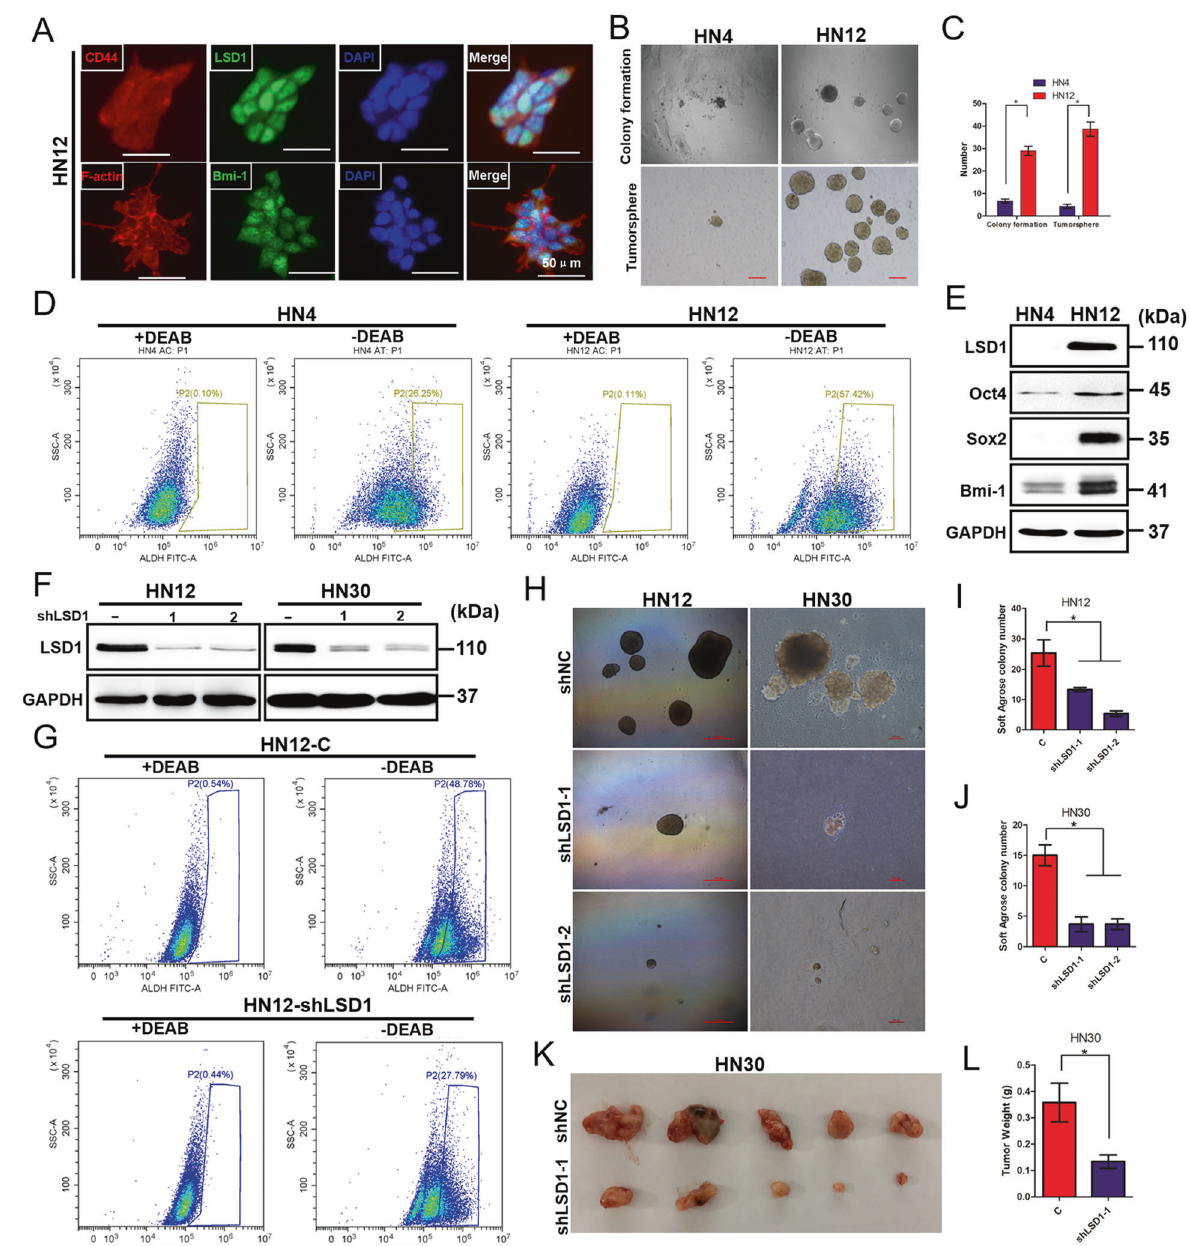
Fig. 2 Elevated LSD1 is important for the maintenance of CSC phenotypes in HNSCC. A Representative coimmuno fl uorescence staining images for LSD1 and the CSC markers Bmi-1 and CD44 in HN12 cells (scale bar, 50 μ m). B Representative images of colony formation and tumorsphere formation by HN4 and HN12 cells. Scale bar = 200 μ m. C Measurement of colony formation and tumorsphere formation (mean ± SD from three separate experiments) by HN12 and HN4 cells. D An Alde fl uor assay was conducted with HN4 and HN12 cells, and the percentage of ALDH-high cells was quanti fi ed by fl ow cytometry. E The expression of LSD1 and CSC-related proteins in HN4 and HN12 cells was detected by western blotting. F Western blot analysis of LSD1 in HN12 and HN30 cells stably expressing a control vector or LSD1-speci fi c shRNA. G An ALDEFLUOR assay was conducted with HN12 LSD1-knockdown and control cells, and the percentage of ALDH-high cells was quanti fi ed by fl ow cytometry. H Images of tumorsphere formation by HN12 and HN30 cells stably expressing a control vector or LSD1-speci fi c shRNA. Scale bar = 200 μ m. I The graph demonstrates the mean ± SD for the tumorsphere number of HN12 cells stably expressing a control vector or LSD1-speci fi c shRNA from three separate experiments. J The graph demonstrates the mean ± SD for the tumorsphere number of HN30 cells stably expressing a control vector or LSD1-speci fi c shRNA from three separate experiments. K , L HN30 cells stably transfected with control or LSD1-speci fi c shRNAs were injected into nude mice. Tumor growth was monitored every 3 days; tumor size and weight were recorded. The data are presented as mean ± SEM from fi ve mice. * P < 0.05 vector control cells compared with corresponding LSD1- knockdown